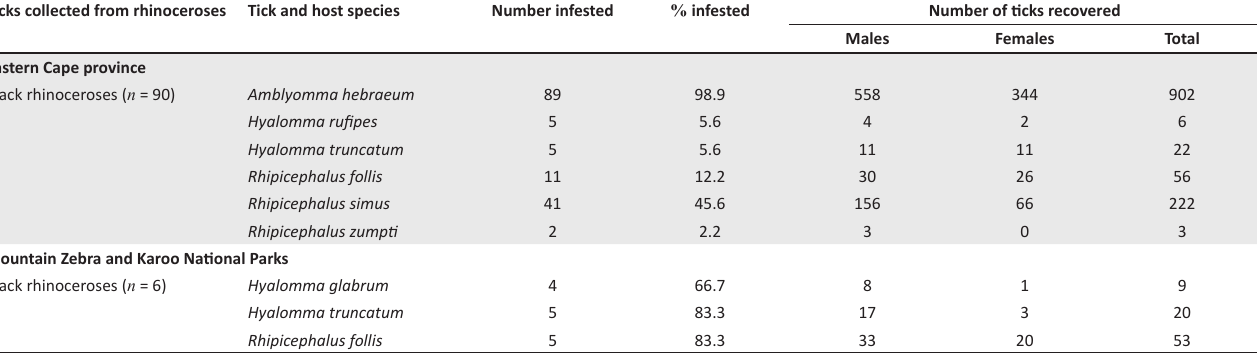
TABLE 4: Ixodid ticks collected from black rhinoceroses in the Great Fish River Nature Reserve and the Addo Elephant National Park, Eastern Cape province, and the Mountain Zebra and Karoo National Parks. Ticks collected from rhinoceroses Tick and host